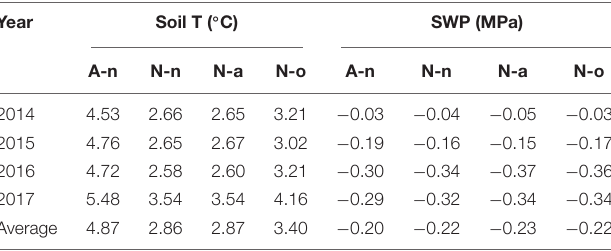
TABLE 1 | Mean annual soil temperature and mean annual soil water potential (SWP) in the four years at the alpine vegetation belt (site A) on its natural soil (A-n) and at the nival vegetation belt (N site) on its natural soil (N-n), on soil originating from site A (N-a), and under the OTC